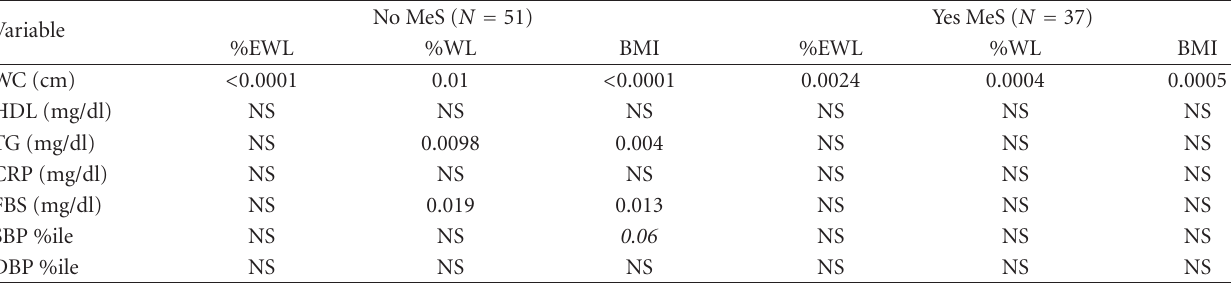
Table 4: P -values for correlations among weight change measures and components of MeS at 6m post-LAGB by MeS status at